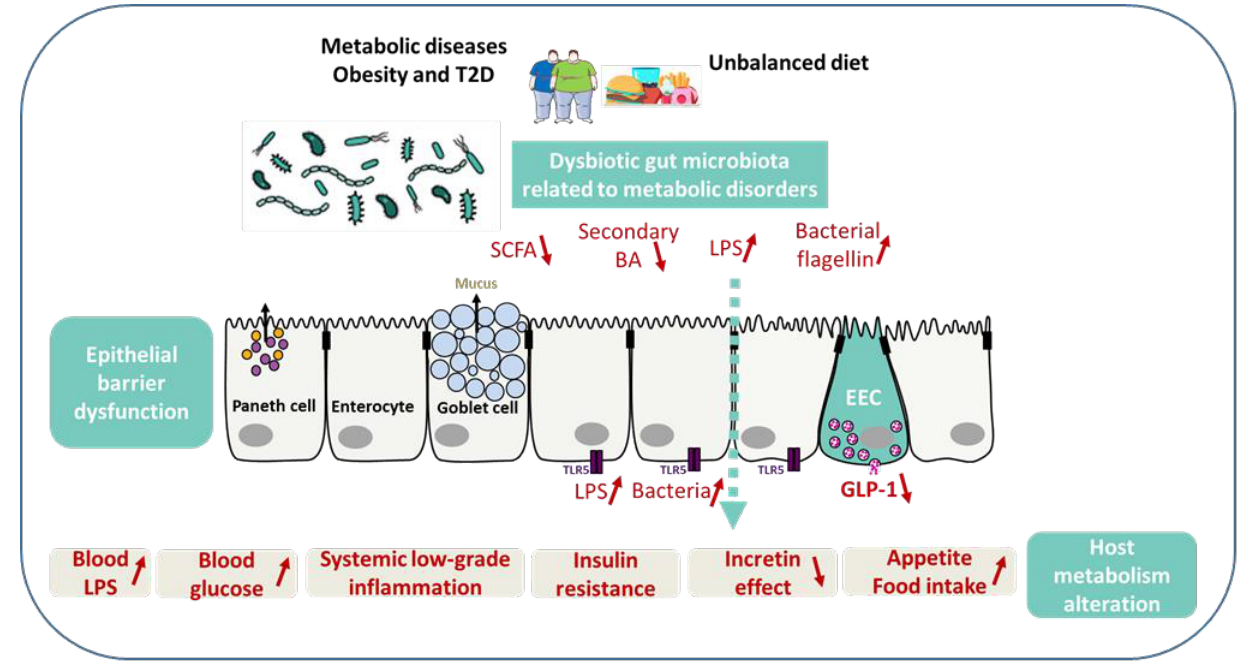
Figure 2. Gut barrier, enteroendocrine cells, and metabolic signals related to metabolic diseases. Unbalanced diet and dysbiotic gut microbiota related to metabolic disorders may result in dysfunction of intestinal barrier integrity, local and systemic inflammation, and reduced production of both SCFA and secondary bile acids, leading to less GLP-1 secretion by EEC. The reduced GLP-1 secretion leads in turn to impaired incretin effect, and an increase of blood glucose, appetite, and food intake. When in excess, LPS prompt intestinal and systemic inflammation and insulin resistance. TLR5, expressed mainly on the basolateral membrane of intestinal epithelial cells, identifies the bacterial locomotion component flagellin for uncovering whether bacteria have crossed the gut epithelia. Aberrantly elevated TLR5 activation might result in damage of the epithelial barrier integrity and inflammation.